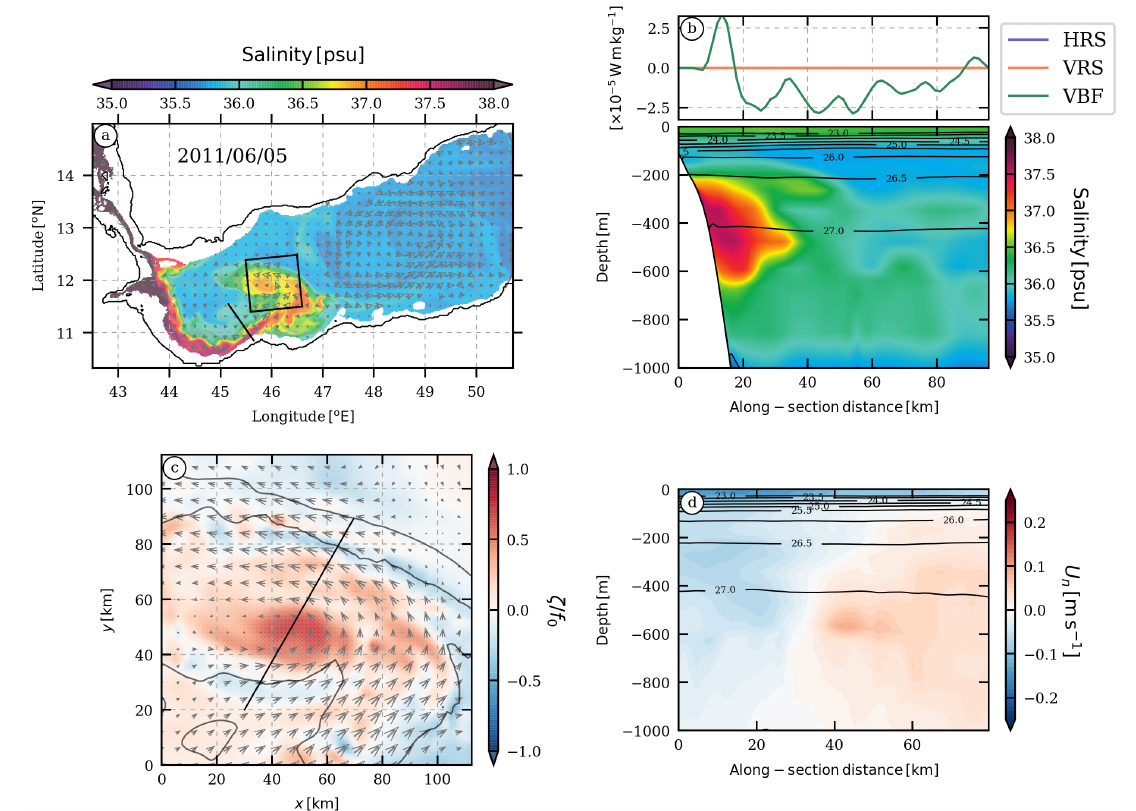
Figure 10. ( a ) Instantaneous salinity interpolated on the σ 0 = 27.0kgm − 3 density level in the Gulf of Aden. Arrows stand for the velocity vectors interpolated on the same density level. ( b , top ) Energy conversion terms integrated from the surface down to 100 m depth, and timely averaged over 20 days centered at the date indicated in ( a ): horizontal Reynolds stress (HRS, in blue), vertical Reynolds stress (VRS, in orange), and vertical buoyancy flux (VBF, in green) in the along-section direction (see solid black line in ( a ) for location). ( b , bottom ) Vertical slice of salinity (see solid black line in ( a ) for location). Density contours are represented as solid black lines. ( c ) Zoom in the Gulf of Aden (see black squared box in ( a ) for location) over a submesoscale anticyclone near the southern coast. Vertical relative vorticity normalized by the Coriolis frequency averaged over the region ( f 0 ) interpolated on the σ 0 = 27.0kgm − 3 density level. Arrows stand for the velocity vectors interpolated on the same density level. ( d ) Vertical slice of the normal velocity (see solid black line in ( c ) for location). Density contours are represented as solid black